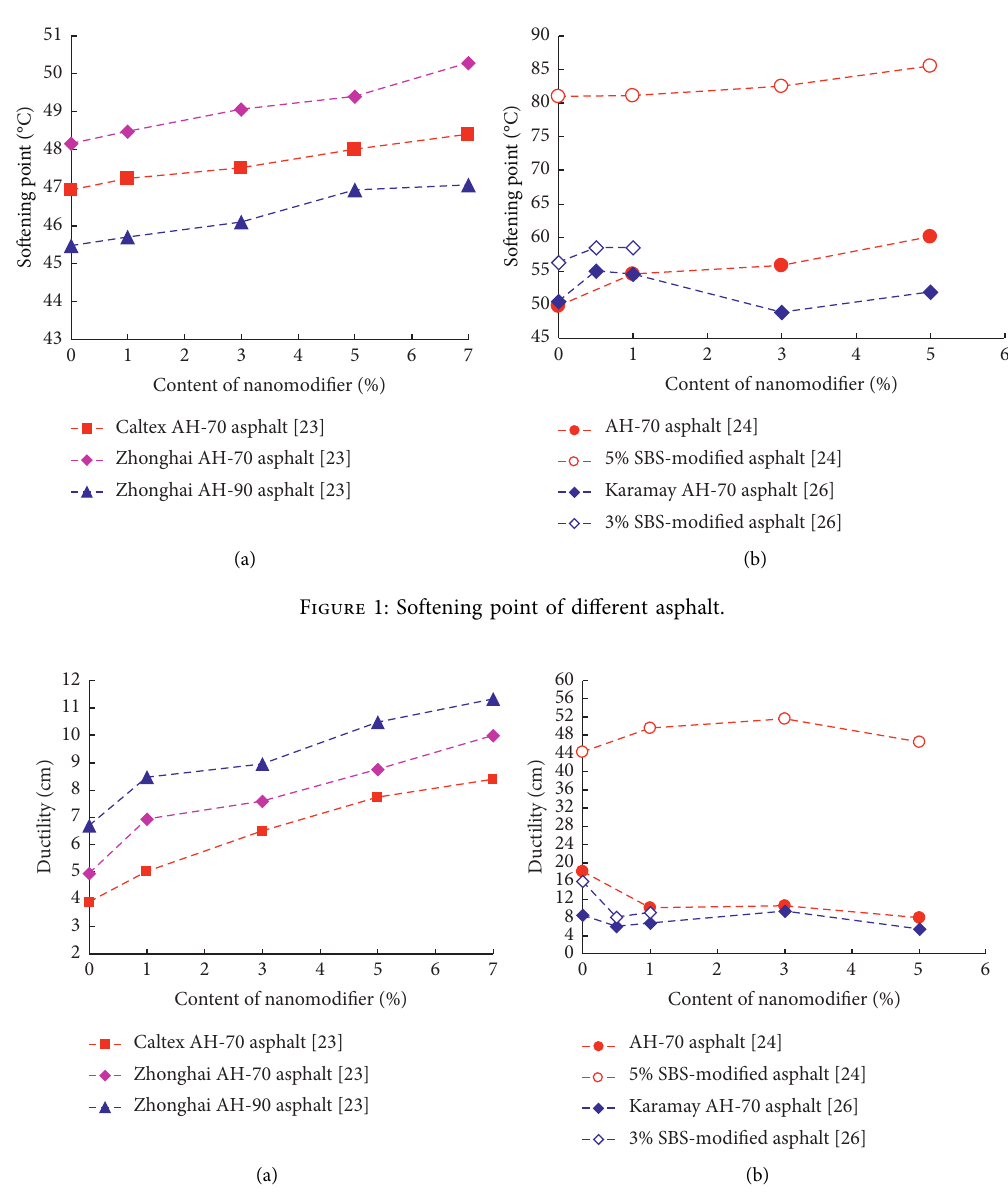
Figure 2: Ductility of different asphalt at 5 °